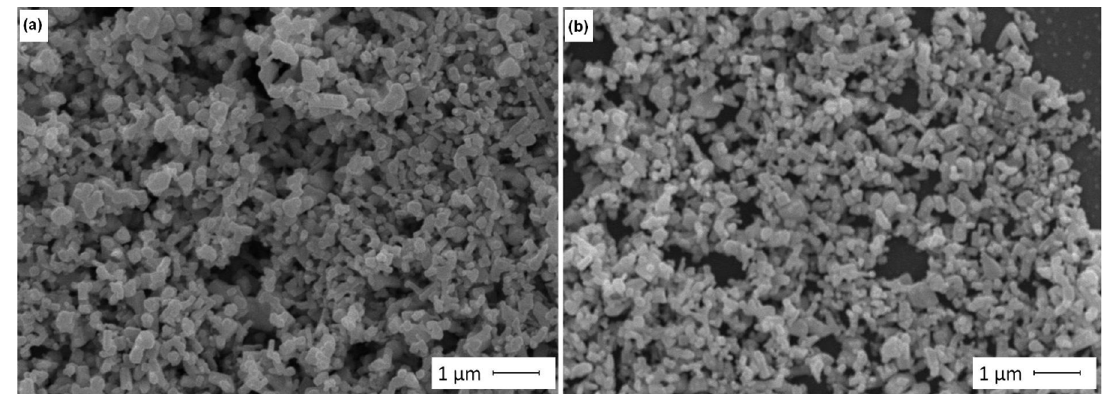
Figure 1. Micrographs of the morphology of the additives: (a) ZnO-Pe and (b) ZnO-WR.